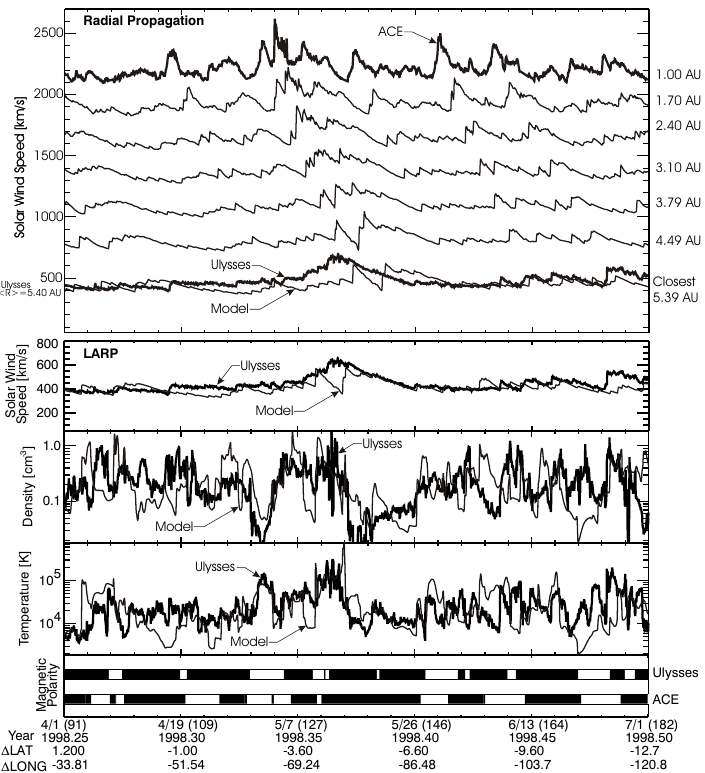
Fig. 1. The top panel shows ACE solar wind speed data at 1 AU as a thick line, and model speeds at given propagation distances as thin lines. The Ulysses data overlays the ACE propagated data at the grid step that most closely matches the distance of Ulysses. Subsequent pan- els compare Ulysses data and model re- sults when the longitudes of the two spacecraft have been aligned in addition to the radial propagation. The second panel displays the velocity, the third panel the density, the fourth panel the temperature, and the last panel the po- larity of the magnetic field. Additional x -axis labels indicate the difference in latitude ( 1 LAT) and longitude ( 1 Lon) between the ACE and Ulysses space-